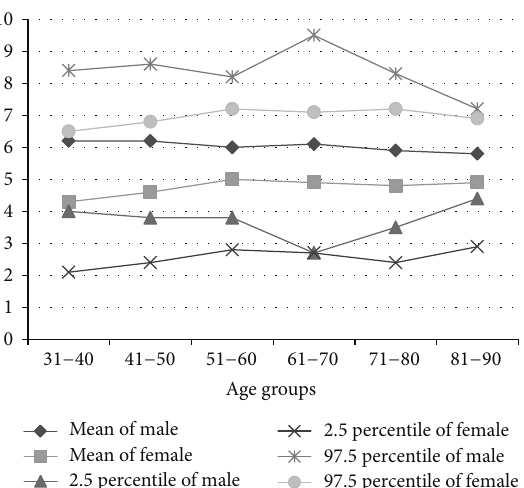
Figure 3: Comparison of results of uric acid between male and